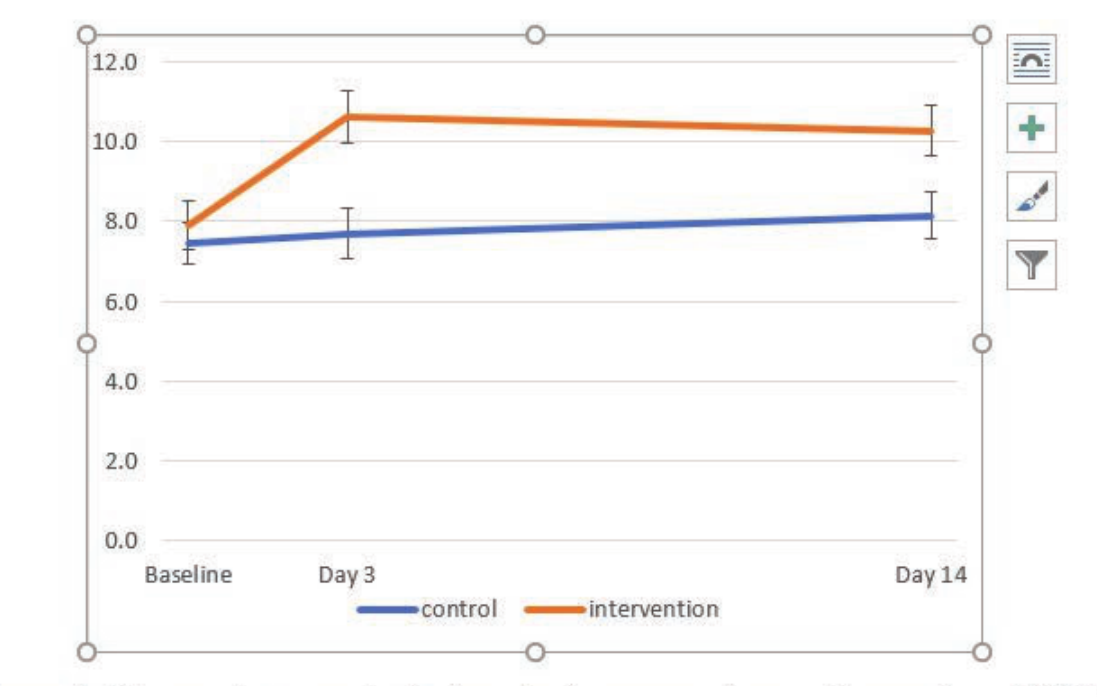
Figure 1. Changes in scores in the two study groups along with error bars (1